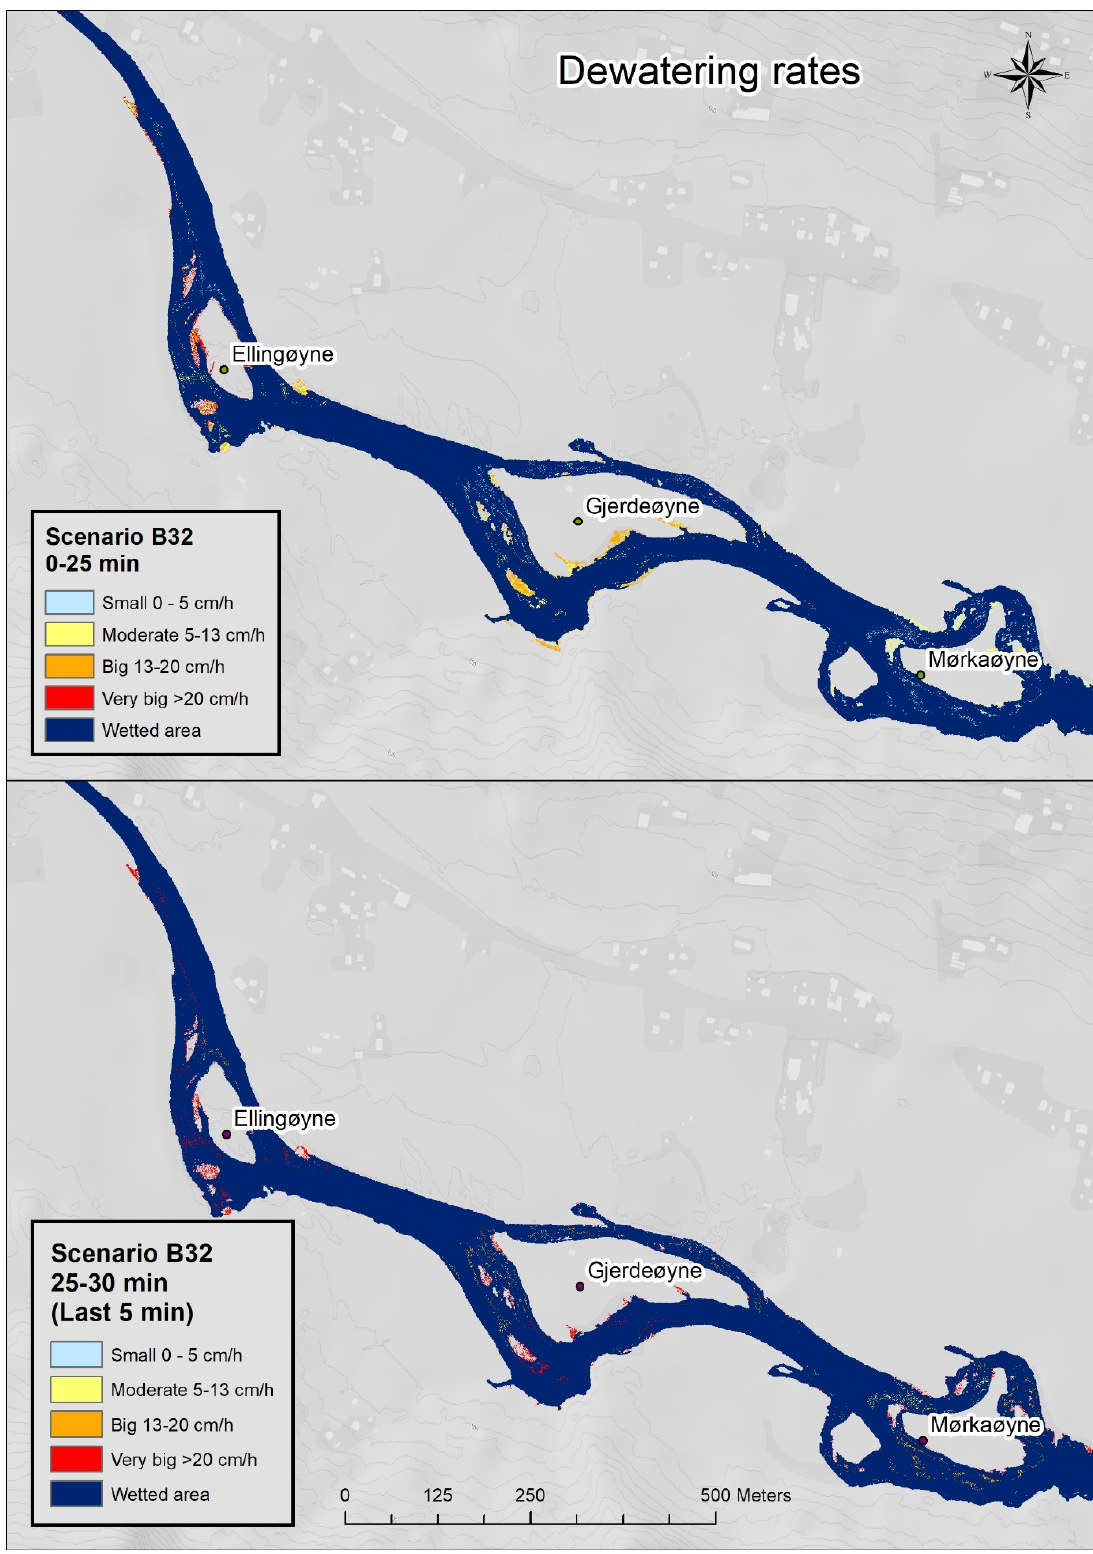
Figure A4. Dewatering rates scenario B32.